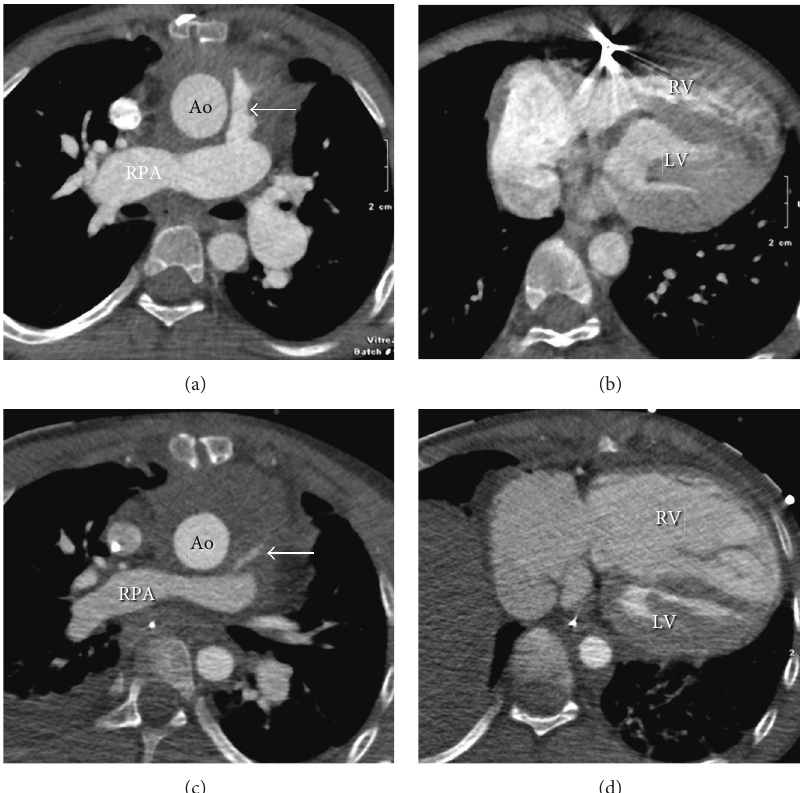
Figure 1: Mediastinitis after Contegra conduit and late complication of large mediastinal fluid collection. ECG-triggered volumetric contrast- enhanced cardiac CT (AquilionONE, Toshiba medical systems, Otawara, Japan) is acquired at end systole (45% of cardiac RR cycle). Transverse views in 8-year male patient with moderate soft tissue/fluid collection around ascending aorta (Ao, in (a)). Relative stenosis of Contegra conduit (arrow, (a)). Patient also had osteolytic destruction of parts of sternum compatible with osteomyelitis (not shown). Diagnosis mediastinitis was based on CT findings and clinical findings. Ventricles at lower level (b). Nine months later; large mediastinal fluid collection and subtotal compression on the Contegra conduit (arrow, (c)). Note the secondary massive right ventricle (RV) dilatation due to outflow obstruction (d). Ao: aorta; LV: left ventricle; RPA: right pulmonary artery. Dose-length products of the CT scans were 26.4 mGy ⋅ cm for the first scan (a, b) and 29.5 mGy ⋅ cm for the second scan (c, d). Correction factor for chest CT at 100 kV for 8 years age was